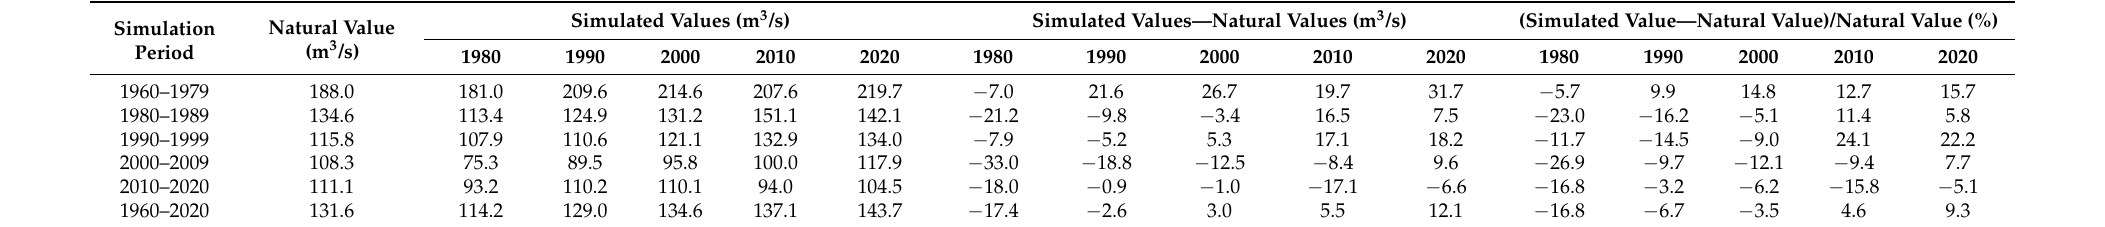
Table 7. Comparative analysis of simulated and natural values of flood peaks under different land-use scenarios. Simulation Period